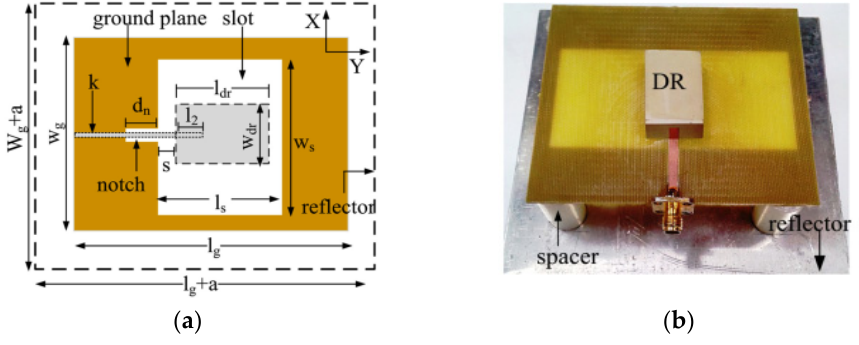
Figure 20. High gain DRA: ( a ) bottom view; ( b ) fabricated prototype [86].